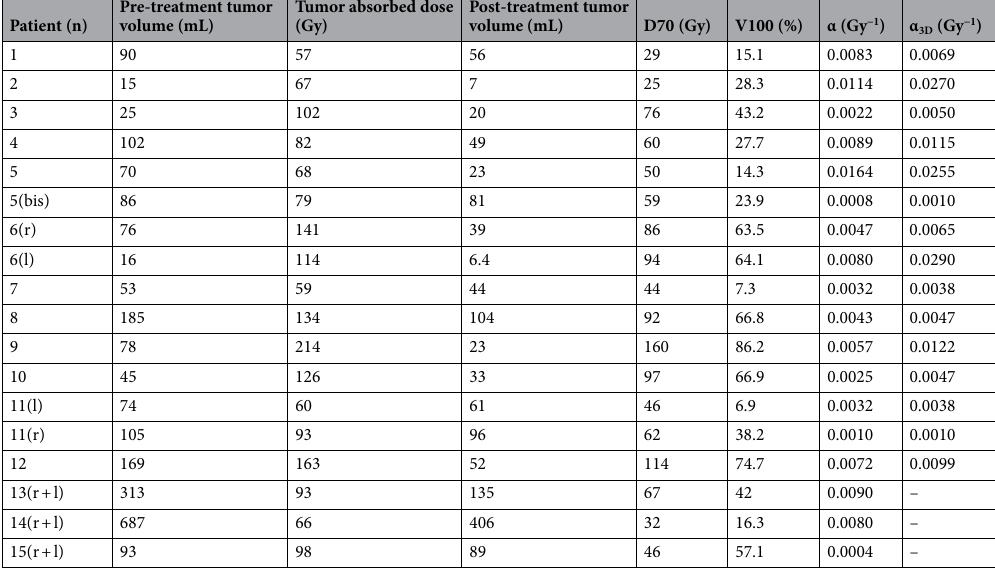
Table 2. Procedural details. (bis): treatment repeated on the same lesion. (r): right liver lobe submitted to SIRT in case of bilobar tumors. (l): left liver lobe submitted to SIRT in case of bilobar tumors. (r + l): mass- forming lesions with bilobar extension treated with two separated procedure whose data were summed (a volume-weighted average was applied for dose and D70 and a dose-weighted average was applied for V100).